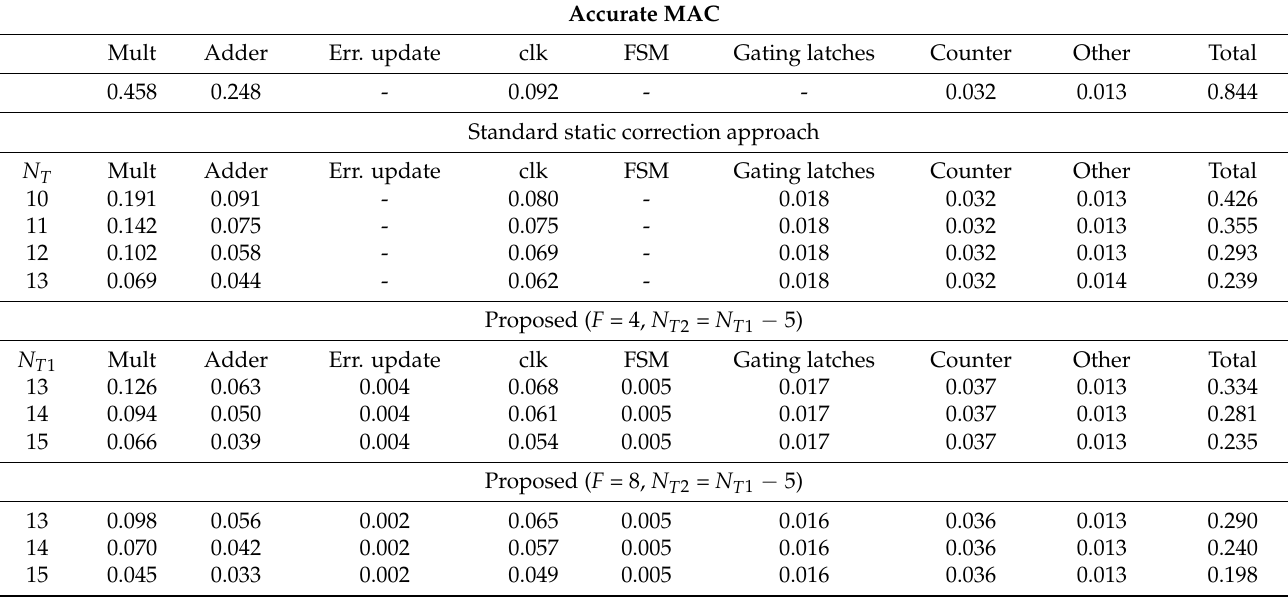
Table 2. Energy dissipation (pJ) of the standard and proposed designs. Accurate